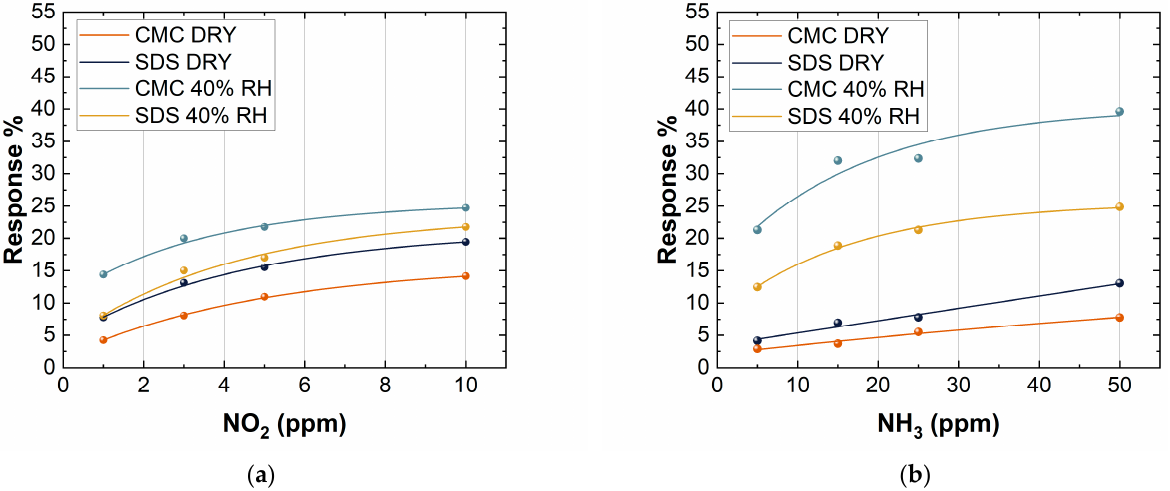
Figure 10. Response of 10 layers of CMC- and SDS-based sensors to the exposure of ( a ) 1, 3, 5, and 50 ppm NO ₂ ; ( b ) 5, 15, 25, and 50 ppm NH ₃ , both in dry conditions and at 40% RH.